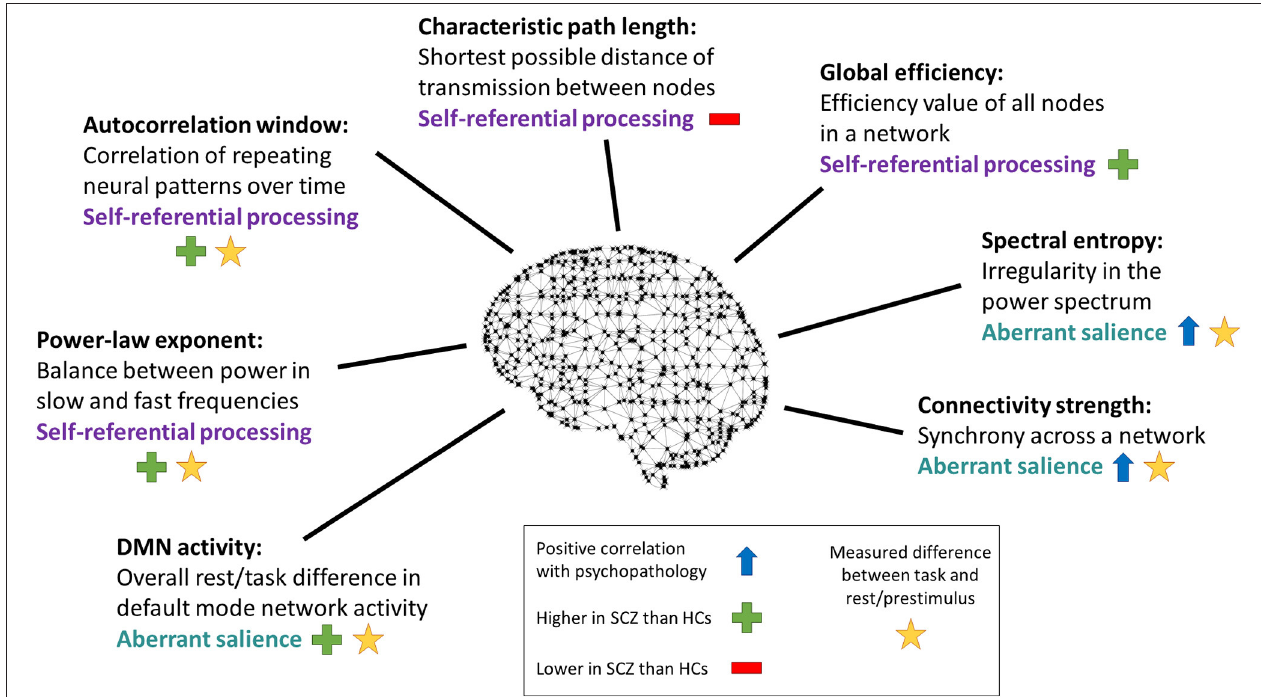
FIGURE 6 | Changes in other dynamic measures. Dynamic measures studied that were not individual frequency bands, labeled with the paradigm used to obtain them. SCZ, subjects with schizophrenia. HCs, healthy controls. With the exception of the study by Kim et al. (16), all of these studies differentiated self-related effects from non-self-related effects either through comparison of experimental conditions or through correlational analyses with psychopathology scales that measure self